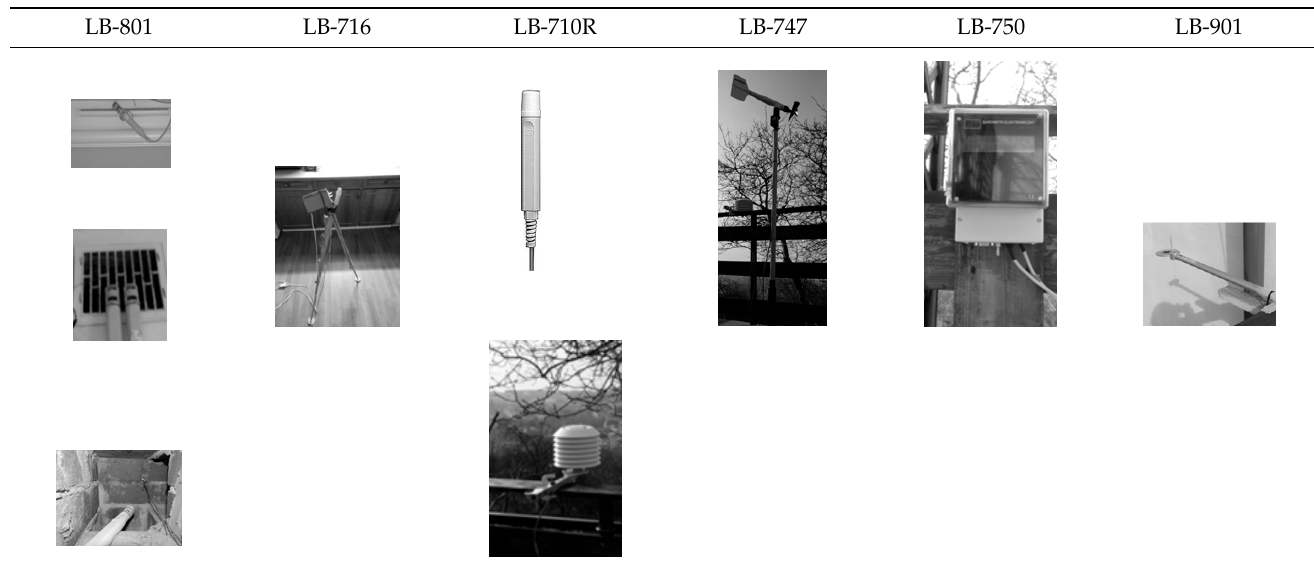
Table 3. The sensors used during in experiment.